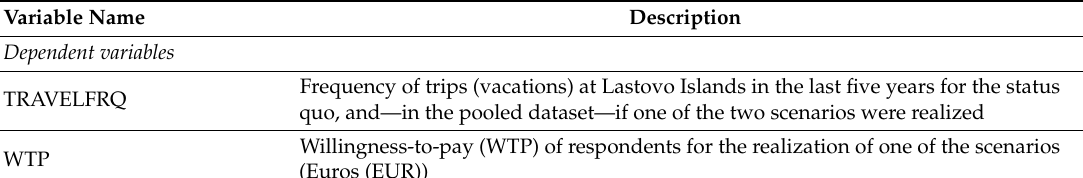
Table 1. Variables of the empirical